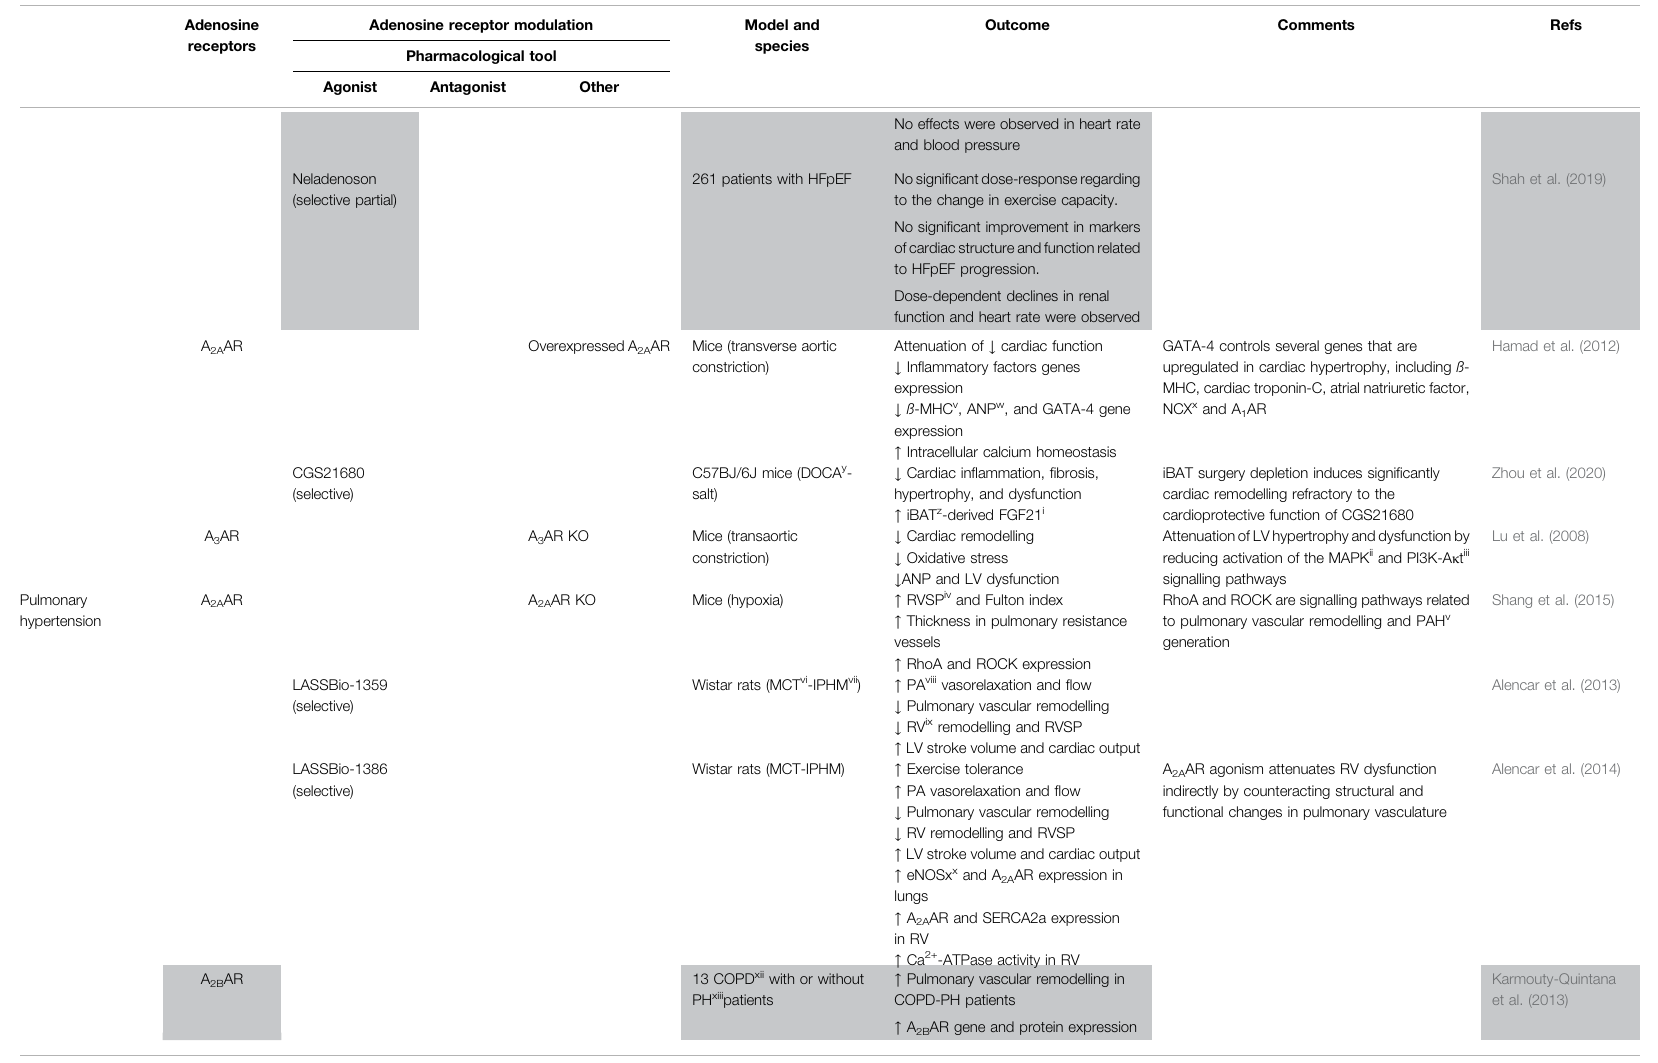
TABLE 1 | ( Continued ) Results of adenosine receptors agonism/antagonism in heart failure with preserved ejection fraction and pulmonary hypertension. Different agonists and antagonists were used to assess adenosine effects on cardiovascular diseases. The grey area corresponds to studies carried out in human patients.